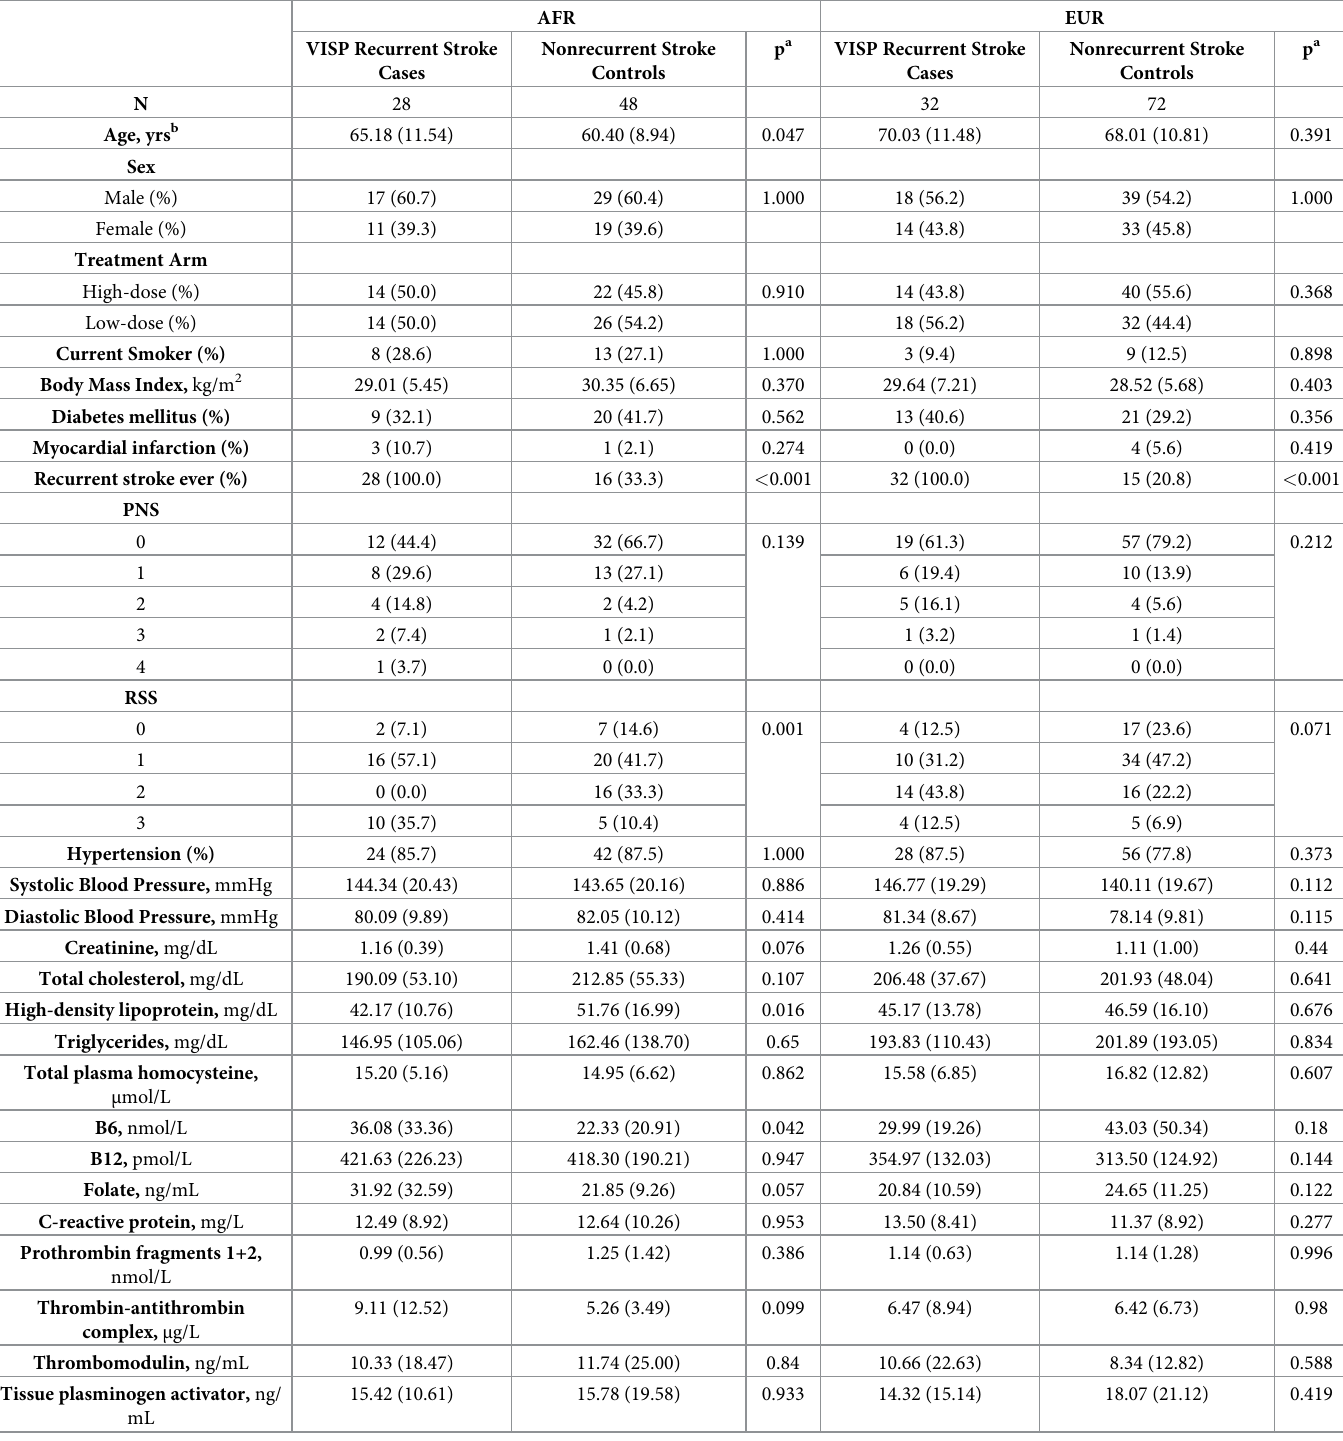
Table 1. Baseline demographics for VISP